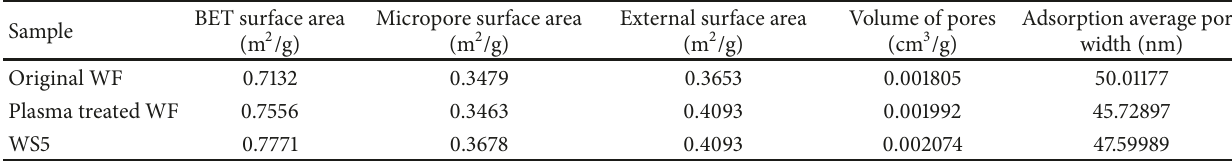
Figure 3: FESEM images of the structure of wood flour (a) before and (b) after plasma treatment. Table 1: Surface area and pore volume of original WF, plasma treated WF, and